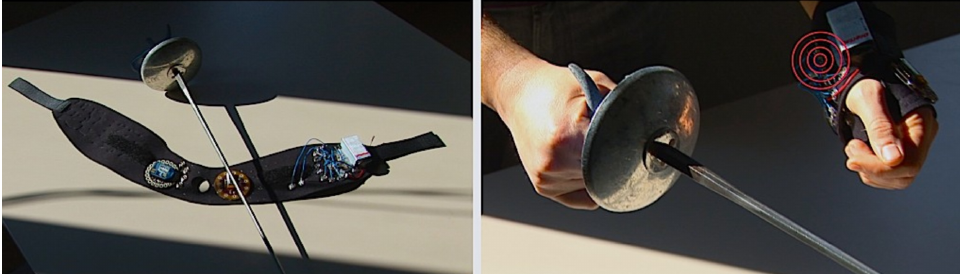
Figure 17. Glove with wrist strap for radio communication from the fencer to the scorekeeper and for actuator